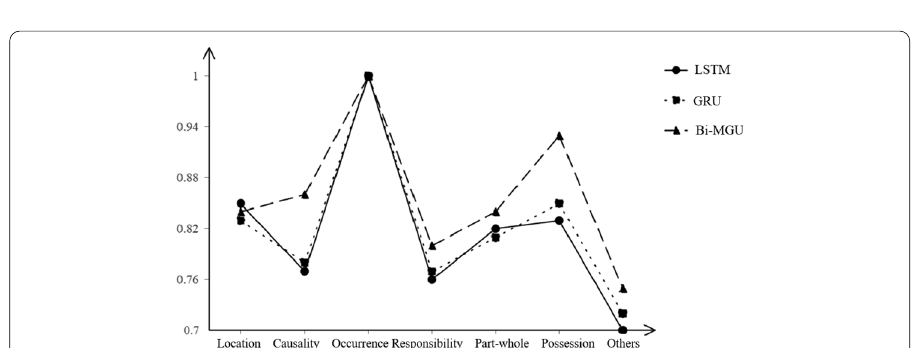
Fig. 6 Comparison on F -Score of different relation extraction approaches, where each type of relation is used as a data point to tease out the effectiveness of the proposed model